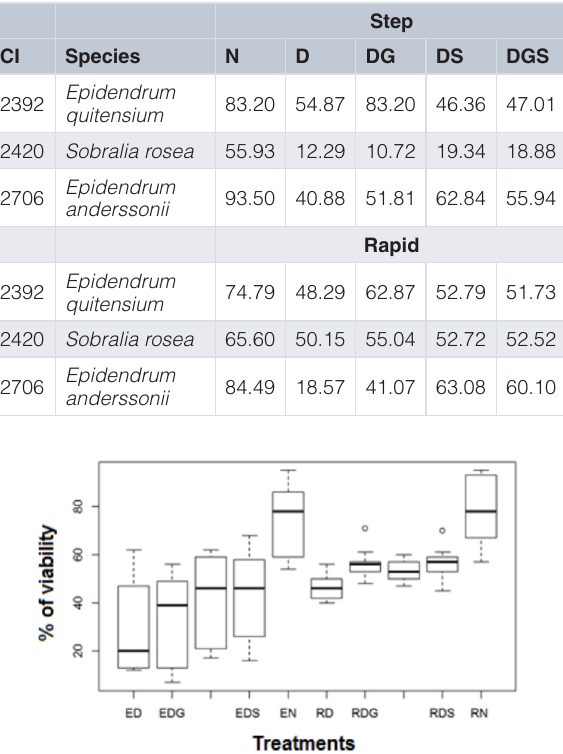
Figure 3. Seed cryopreservation: variability by treatment. Results obtained using the Tukey